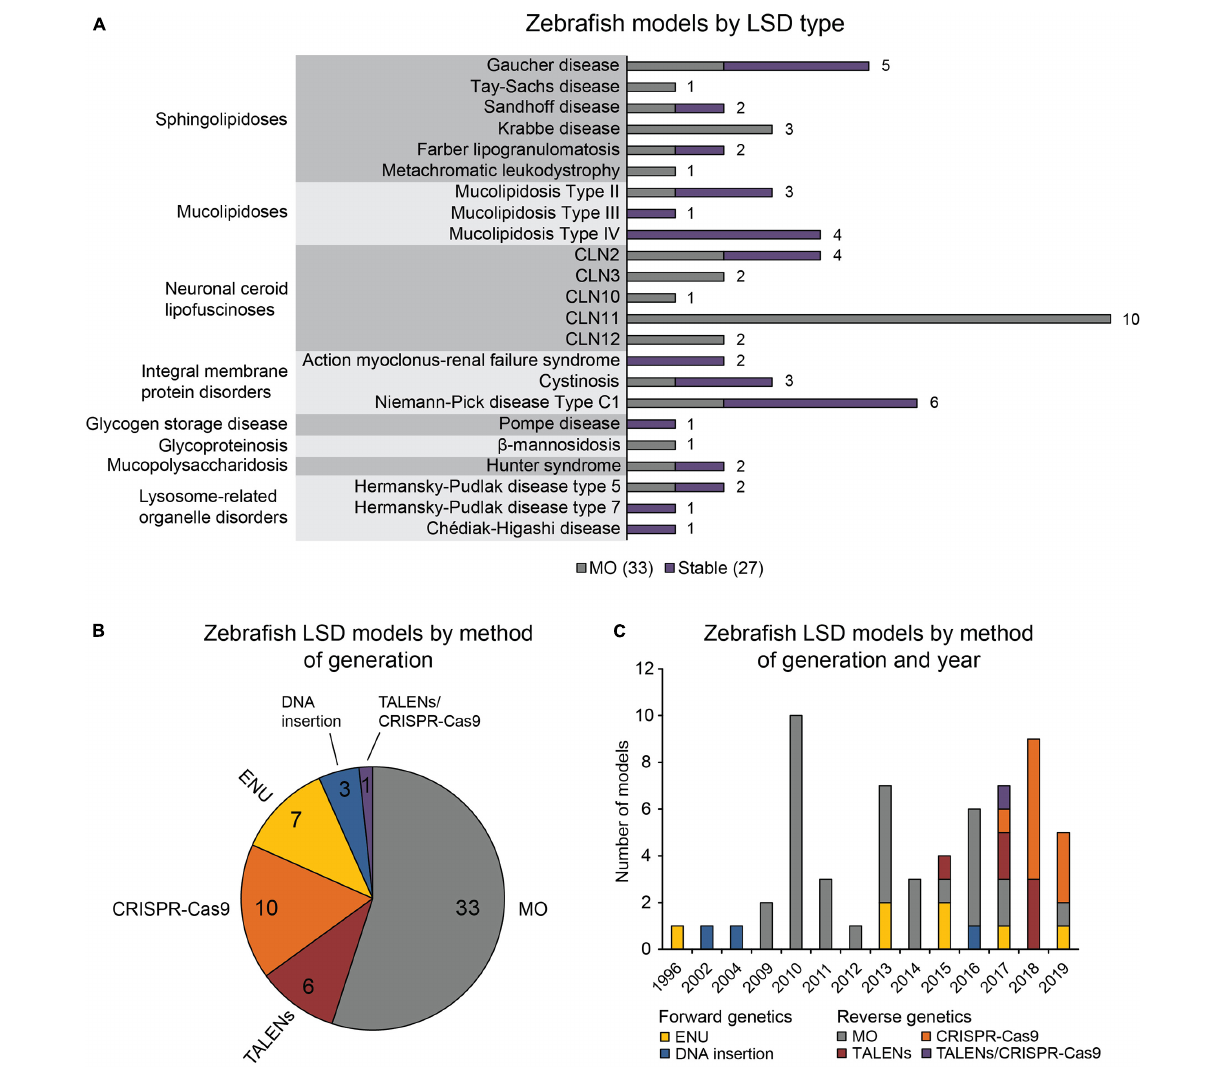
FIGURE 1 | Zebrafish LSD models, a statistical overview. (A) Zebrafish LSD models by disease type. Numbers in the bar graph denote total number of published zebrafish models for each LSD. Transient knockdowns (MOs) and stable mutants are indicated. (B) Zebrafish LSD models by method of generation. (C) Zebrafish LSD models by method of generation and year. Year refers to the earliest year in which phenotypic data were first